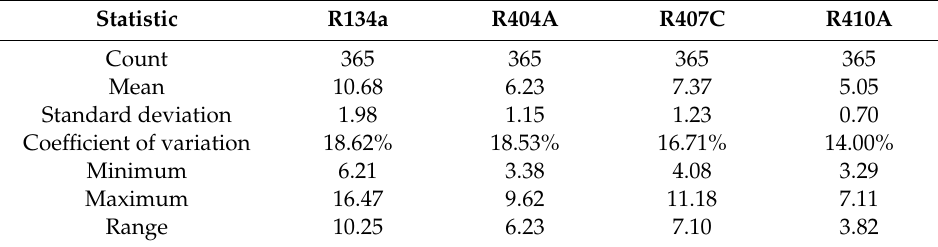
Table 9. Main statistics of the optimized coe ffi cient of performance.